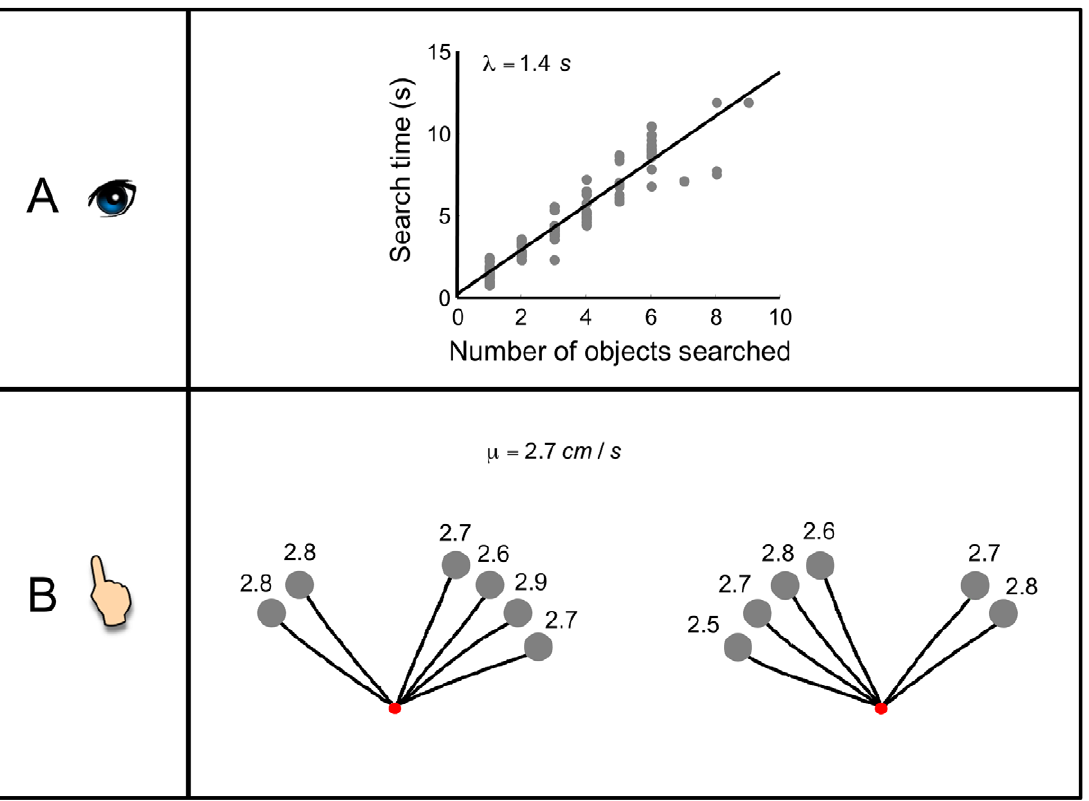
Figure 3. Search slope and movement speed. A. Search time as a linear function of number of objects searched . Data of a typical observer, O7, in the free search task. Each grey dot is for one trial. The black line is the fitting line, whose slope corresponds to the time to identify one object, l . B. Average trajectories for different target positions . Data of the same observer O7 in the training of reach. Red filled circle denotes the starting position. Grey filled circles denote positions of objects. In each trail, the observer moved the finger from the starting position to one designated position. Black lines denote trajectories of hand movement averaged across trials. The number above an object denotes the measured movement speed towards the object ( cm/s ). Note that the movement speeds differ little in different movement directions. The mean speed across all target positions is regarded as the observer’s movement speed, m .